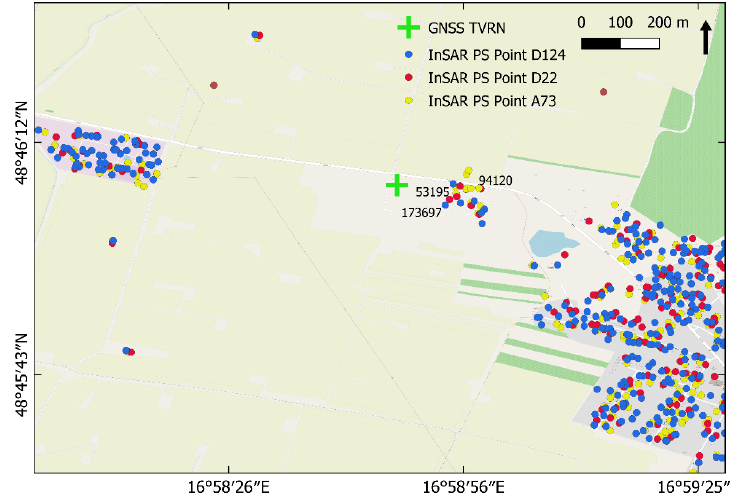
Figure 14. Position of PS points from the InSAR processing near the GNSS TVRN station (green cross). Points from ascending track A73 are shown in yellow, points from descending track D124 in blue, and descending track D22 in red.